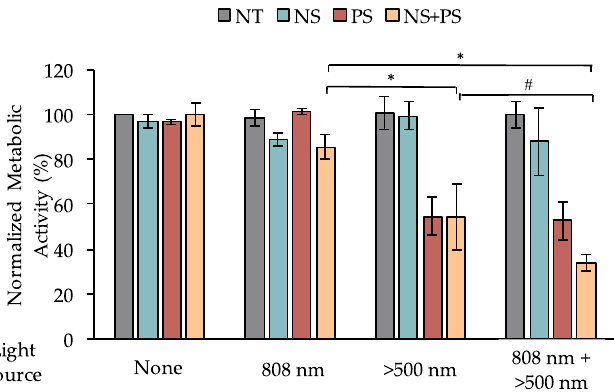
Figure 5. Normalized metabolic activity of MDA-MB-231 TNBC cells following treatment with PEG-NSs and/or the Pd[DMBil1]-PEG 750 PSs for 24 h followed by irradiation with 808 nm and/or λ exc > 500 nm light sources. # p = 0.06 and * p < 0.05 by 1-way ANOVA with post hoc Tukey.